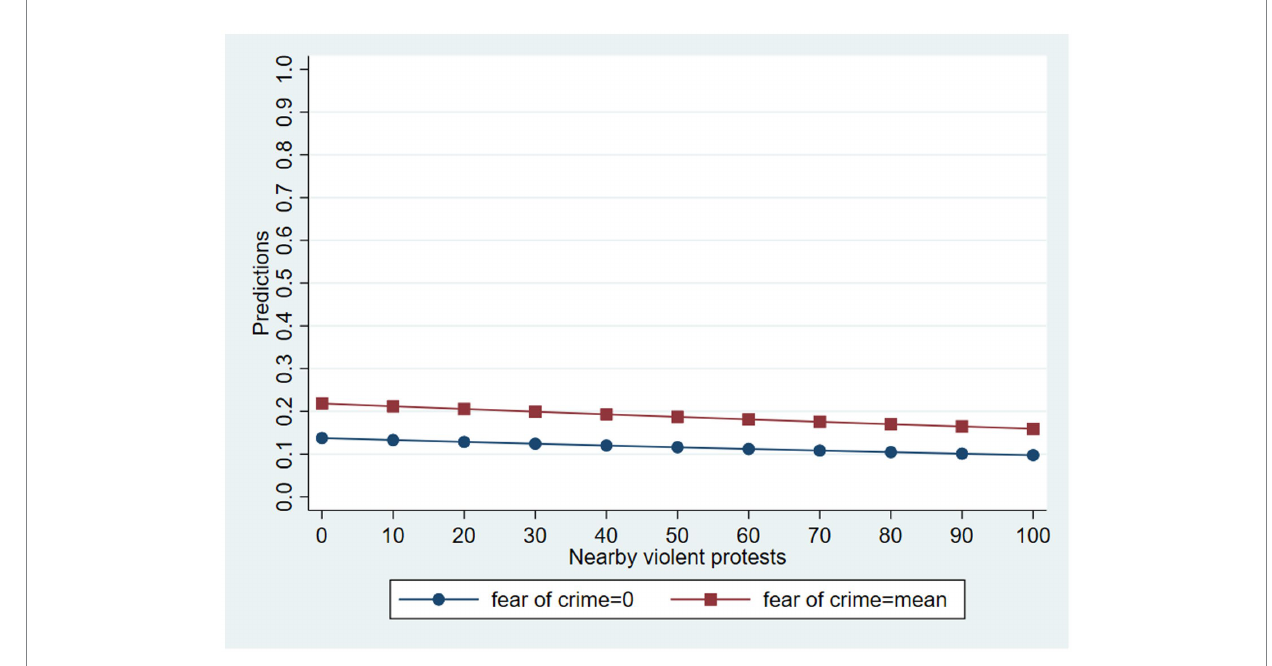
FIGURE 5 Adjusted predictions of stating that the armed forces violated human rights “very